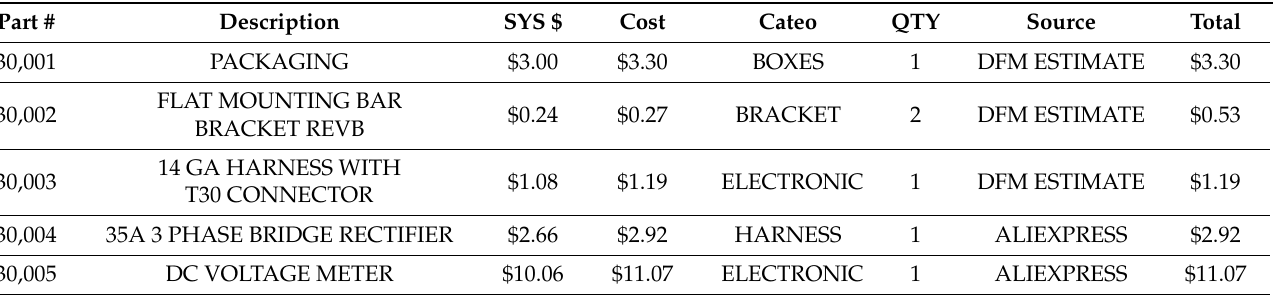
Table 6. Costed BOM for the exercise bike energy